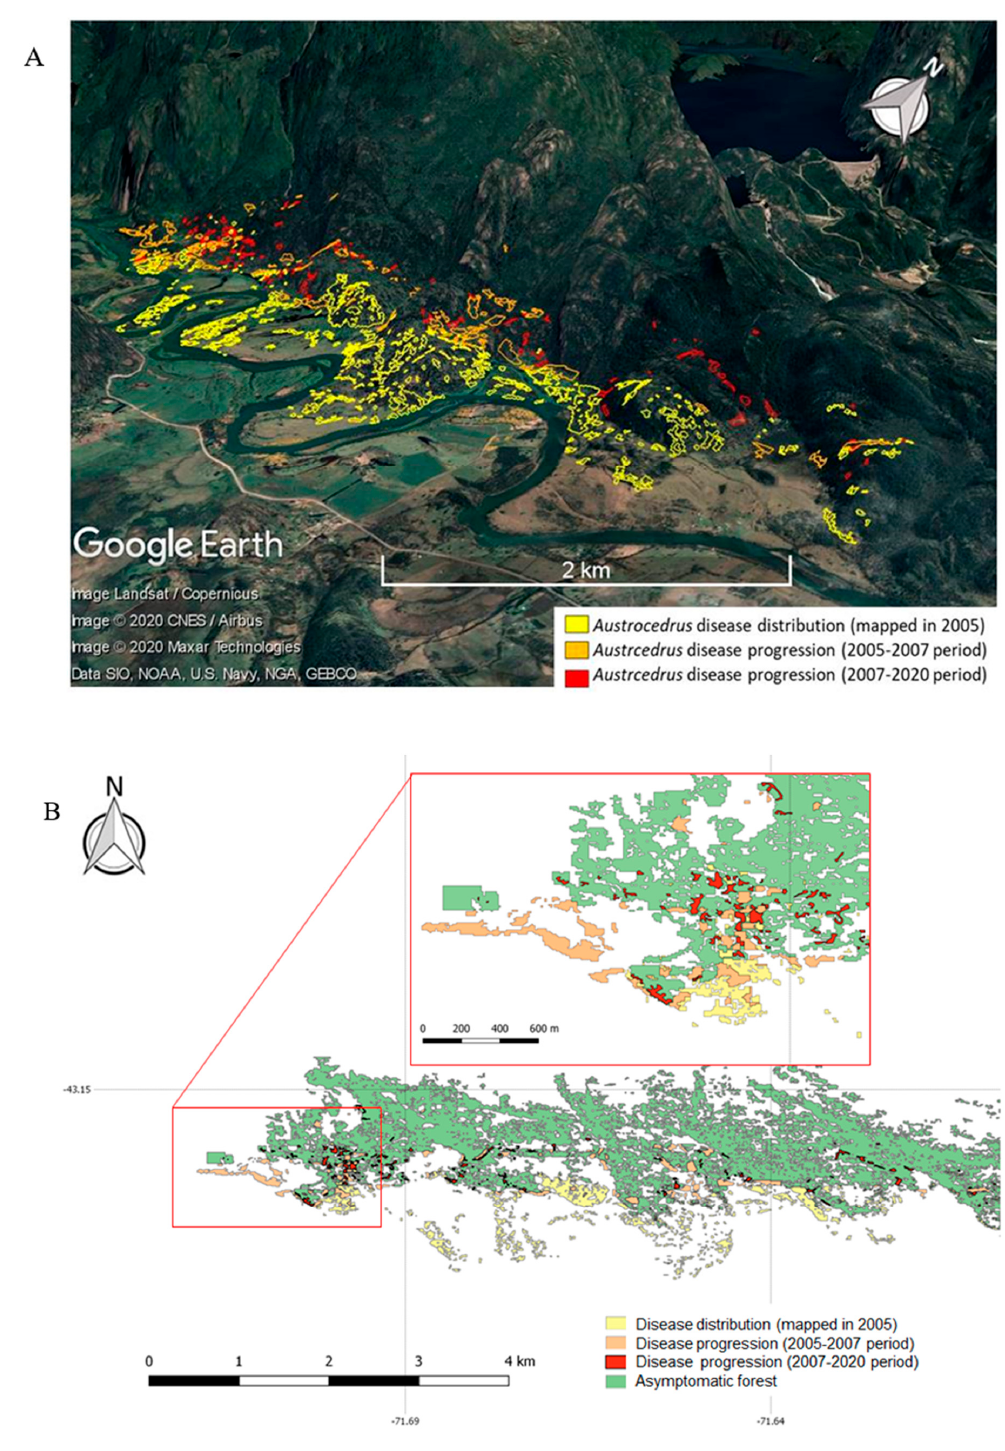
Figure 4. Austrocedrus disease distribution over time in an area from Los Alerces National Park. ( A ) Diseased forest distribution. ( B ) Distribution of diseased and asymptomatic forests.